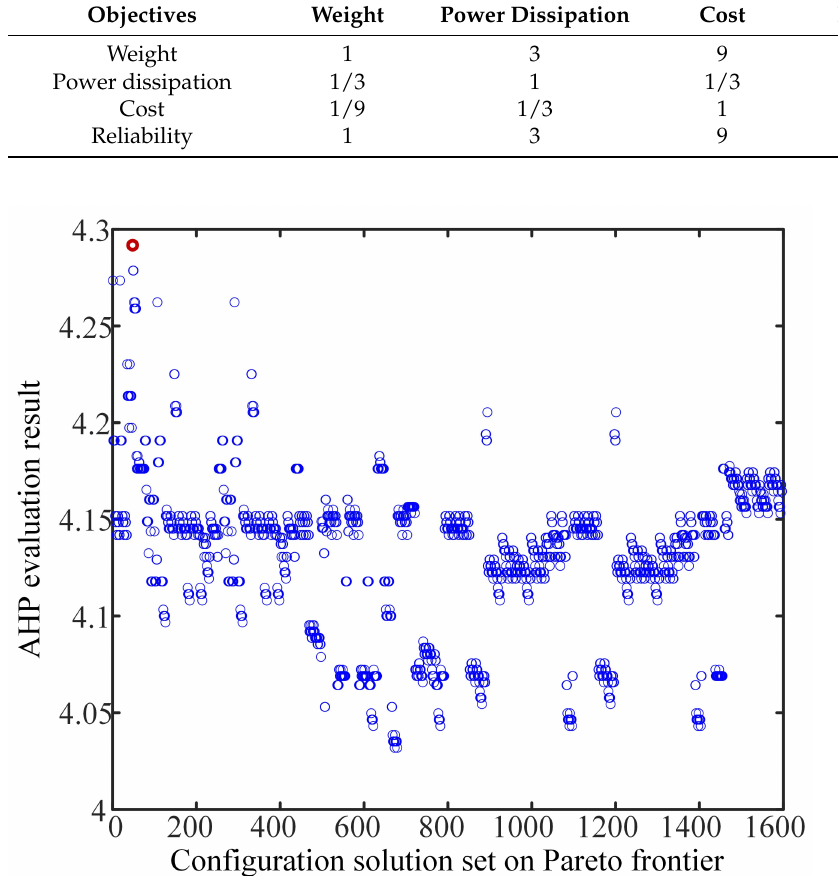
Figure 15. AHP assessment outcomes of Pareto frontier.